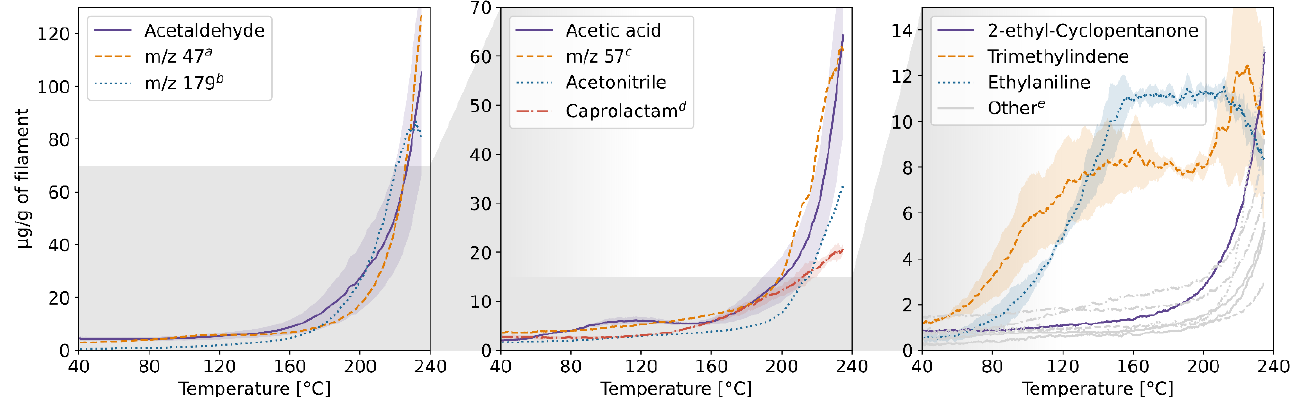
filament. a,b,c,d see Figure 3 caption.